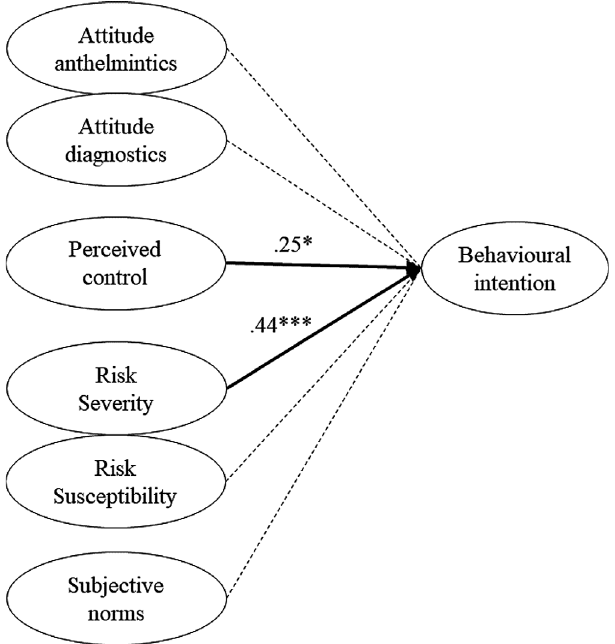
Figure 2. Structural equation model predicting dairy farmers ’ adoption of diagnostic methods for control of gastrointestinal nematode infections in Italy (N = 302). Notes. Full lines represent the signi fi cant equations with the numbers representing standardized regression coef fi cients; dotted lines represent insigni fi cant equations. *** p < 0.001, ** p < 0.01, * p <